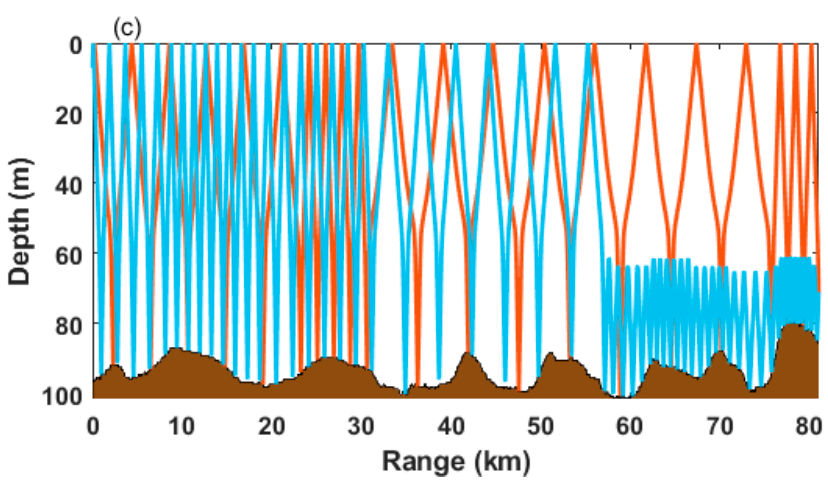
Figure 12. Eigen rays from the source to the receiver in the range of 80 km with central frequency 1000 Hz: ( a ) T1O, source depth 7 m, receiver depth 11 m; ( b ) T3O, source depth 7 m, receiver depth 11 m; and ( c ) T1O, source depth 7 m, receiver depth 71 m.